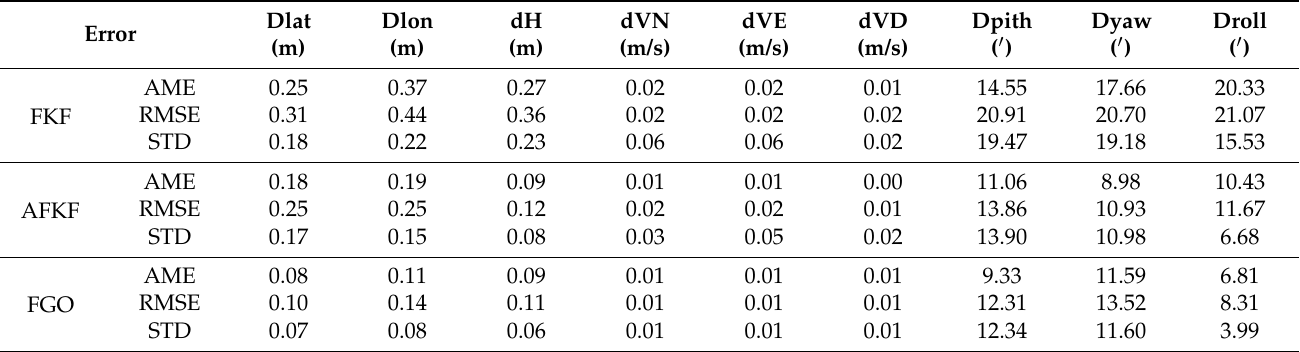
Table 4. Error statistics of different algorithms.